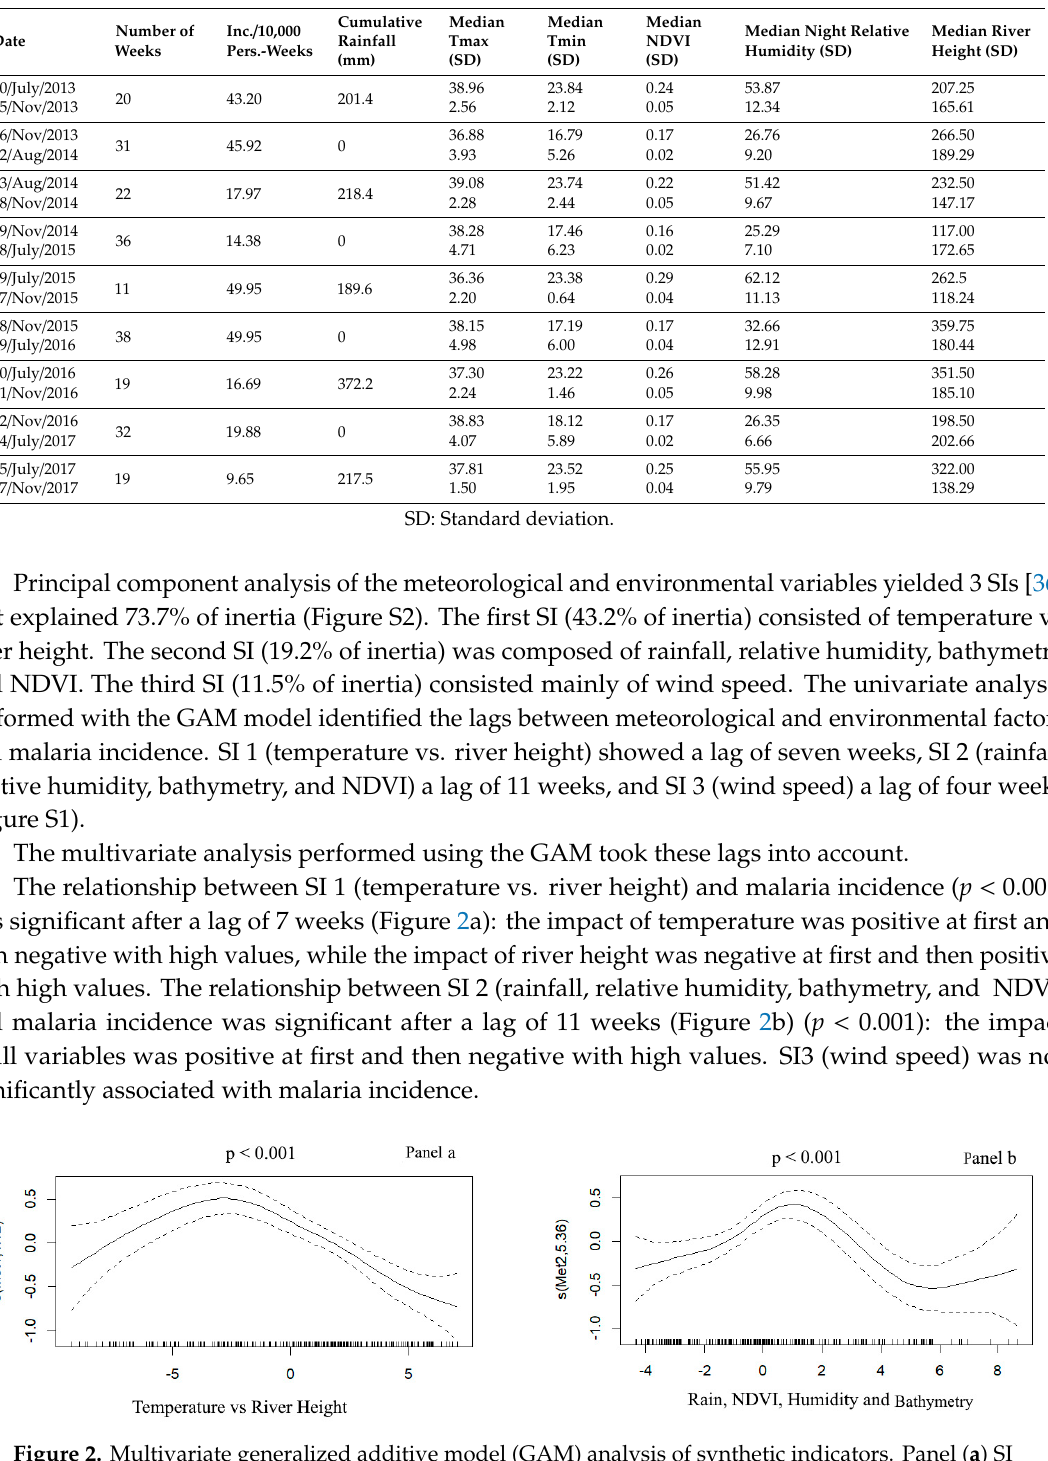
Table 1. Meteorological and environmental data and malaria incidence by time period.